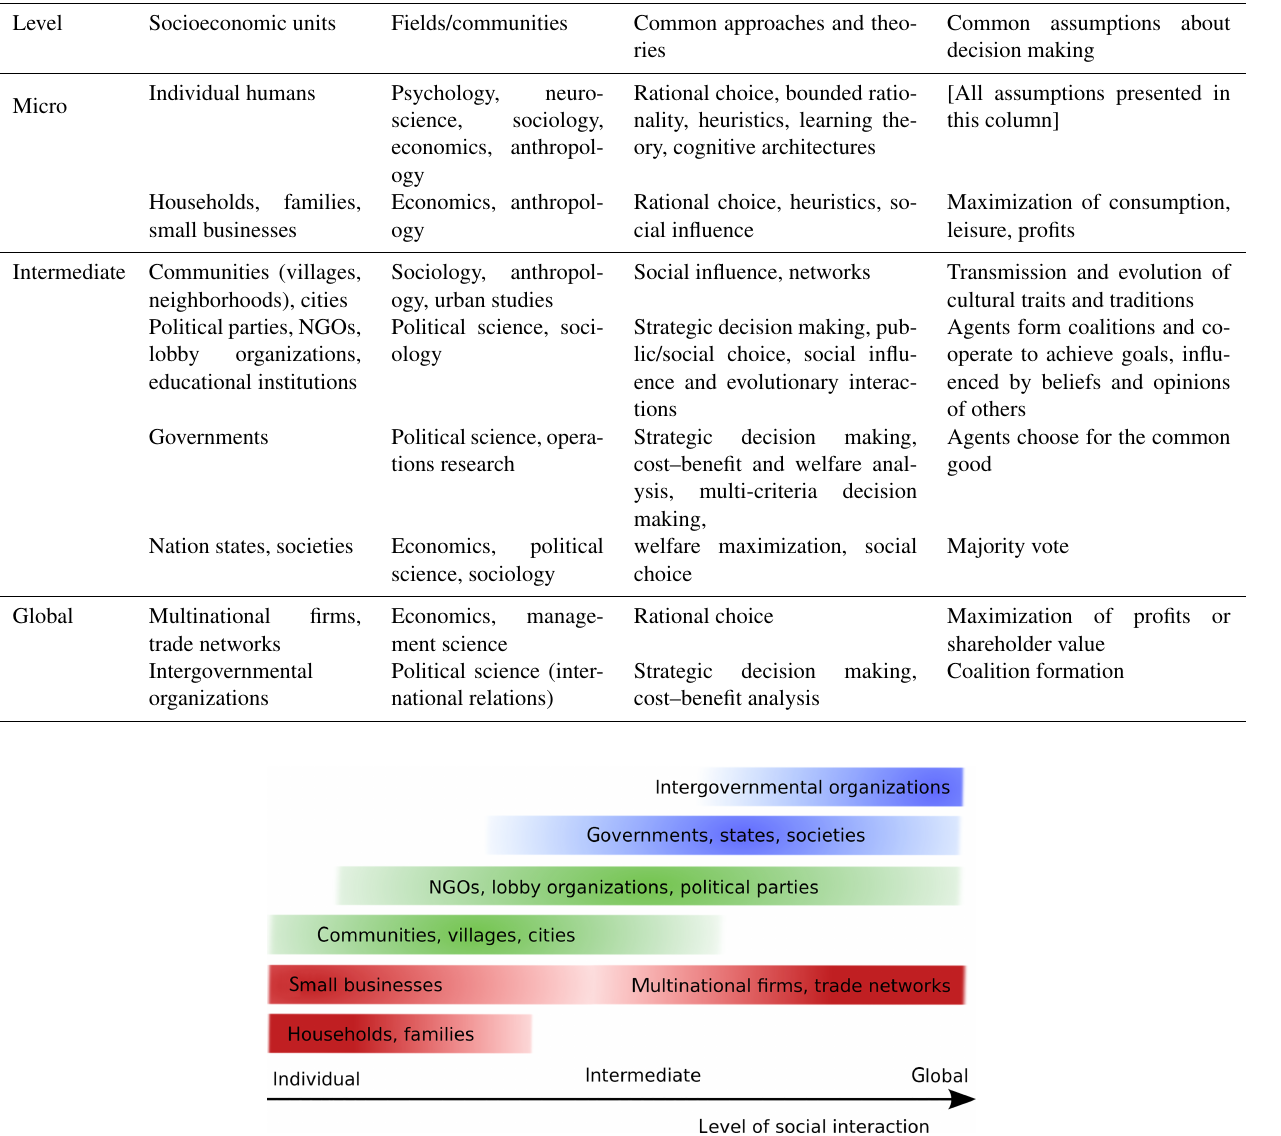
Table 1. Overview of particular levels of description of socioeconomic units, associated scientific fields and communities, and some common approaches and assumptions about decisions and behavior. The list gives a broad overview but is far from being exhaustive.